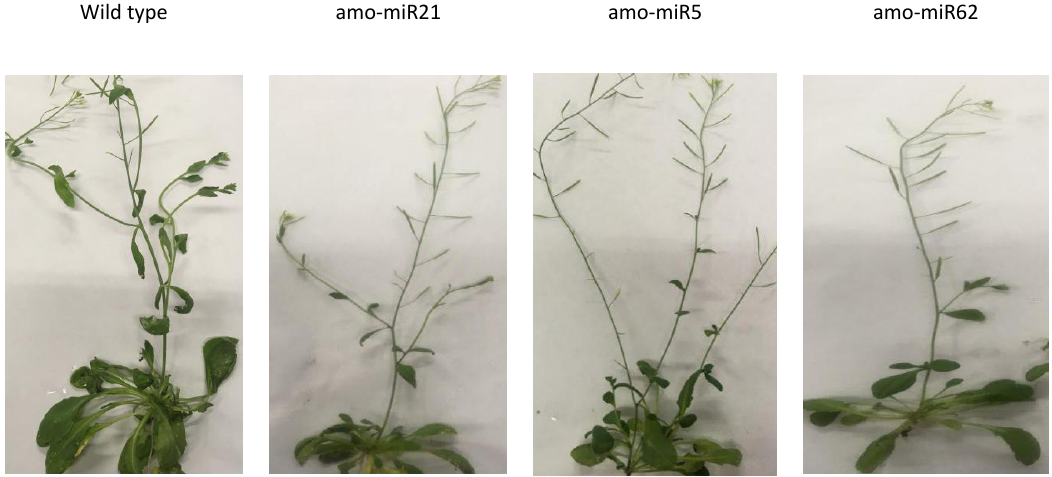
Figure 10. Phenotype of transgenic Arabidopsis lines at 18 h under 15% PEG treatment.